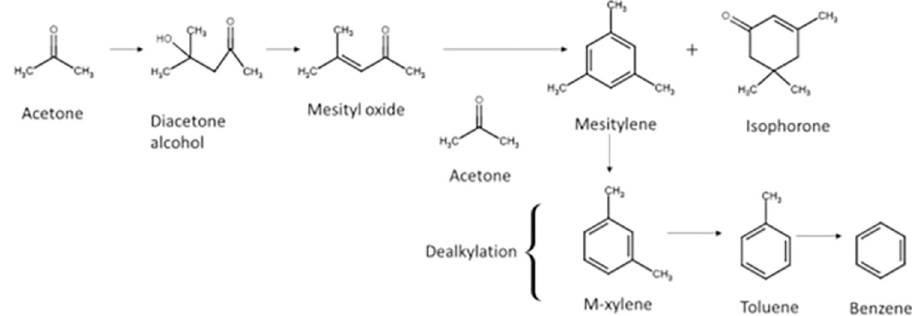
Fig 11. Reaction pathway proposed in the aldol condensation of acetone using